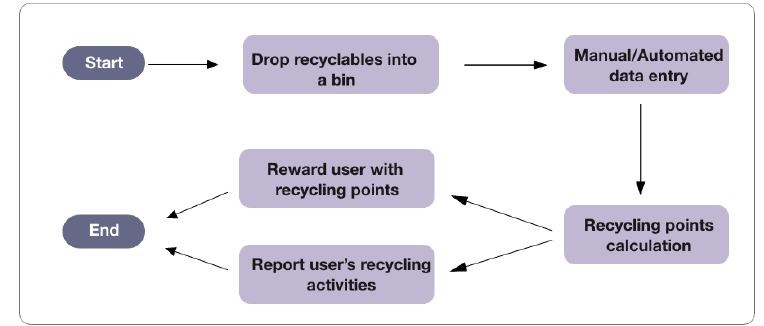
Figure 1. Waste management system